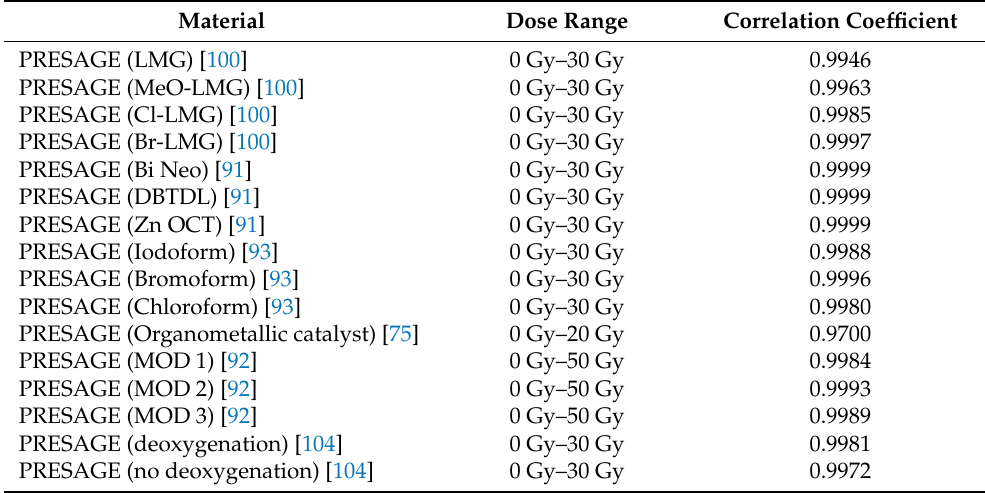
Table 3. The correlation coefficient that represents degree of linearity for various PRESAGEs. Material Dose Range Correlation